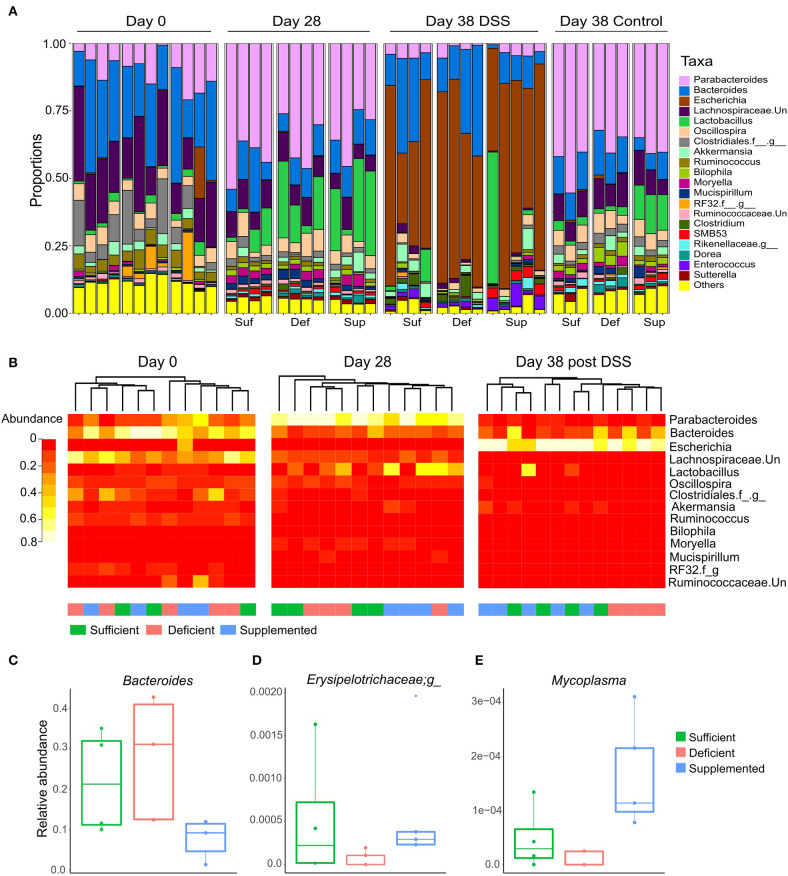
(A) Dominant shifts in the top 20 taxa relative abundance at the genus level in response to dietary vitamin B12 treatments and DSS-induced colitis. (B) Hierarchical clustering of top 25 taxa at the genus level at days 0, 28, and for DSS-induced colitis, day 38. Clustering was observed for vitamin B12 supplemented animals at day 28, which was eliminated following DSS-induced colitis. Clustering of the vitamin B12 deficient group was noted following induction of colitis at day 38. Relative abundance of taxa was significantly different between treatment groups at day 38 following DSS-induced colitis (Kruskal Wallis, FDR <0.1) (C)
Bacteroides, (D) unclassified member of the Erysipelotrichaceae family, and (E)
Mycoplasma.